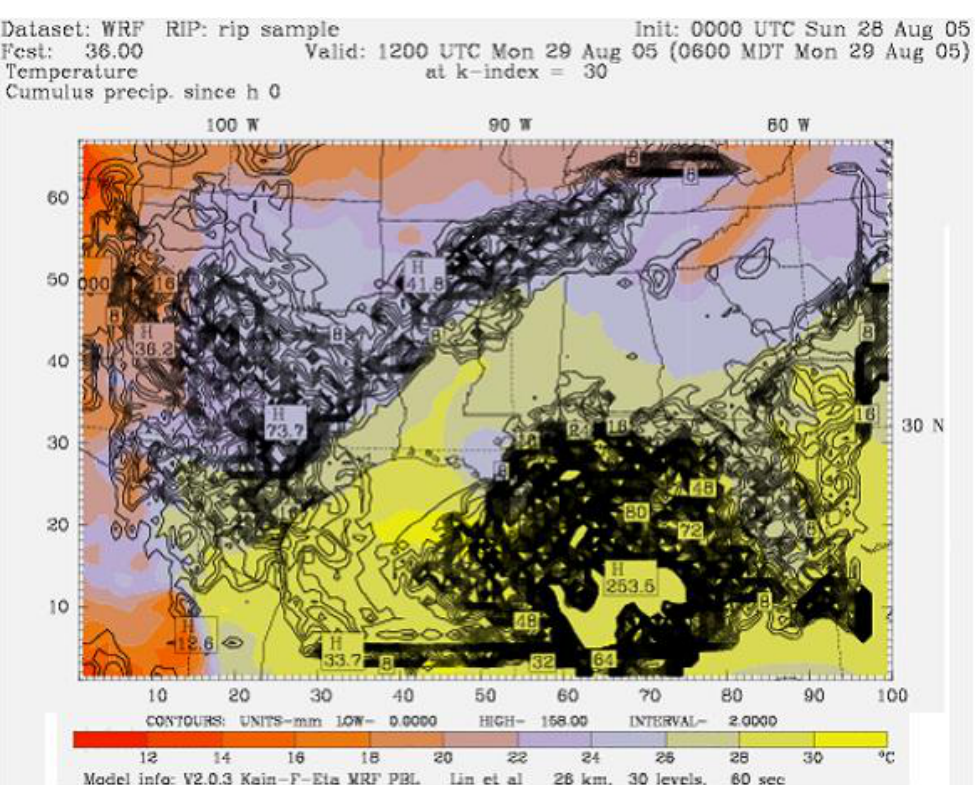
Figure 9. Modeling simulations of cumulative precipitation of hurricane Katrina with a maximum of 253 mm, at the time of Land Fall on 28 August